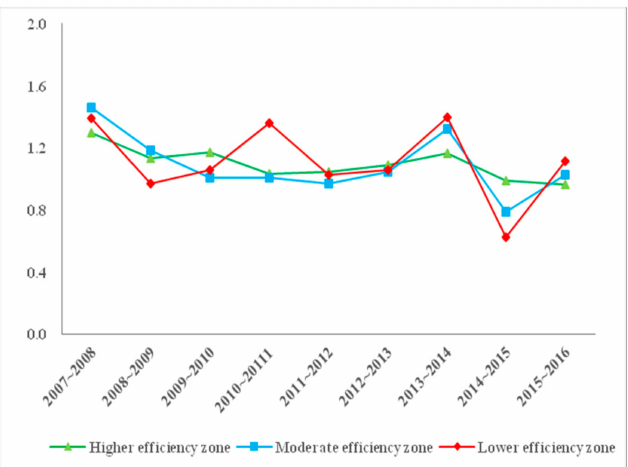
Figure 4. The line chart of average ML values of higher, moderate and lower e ffi ciency zones from 2007 to